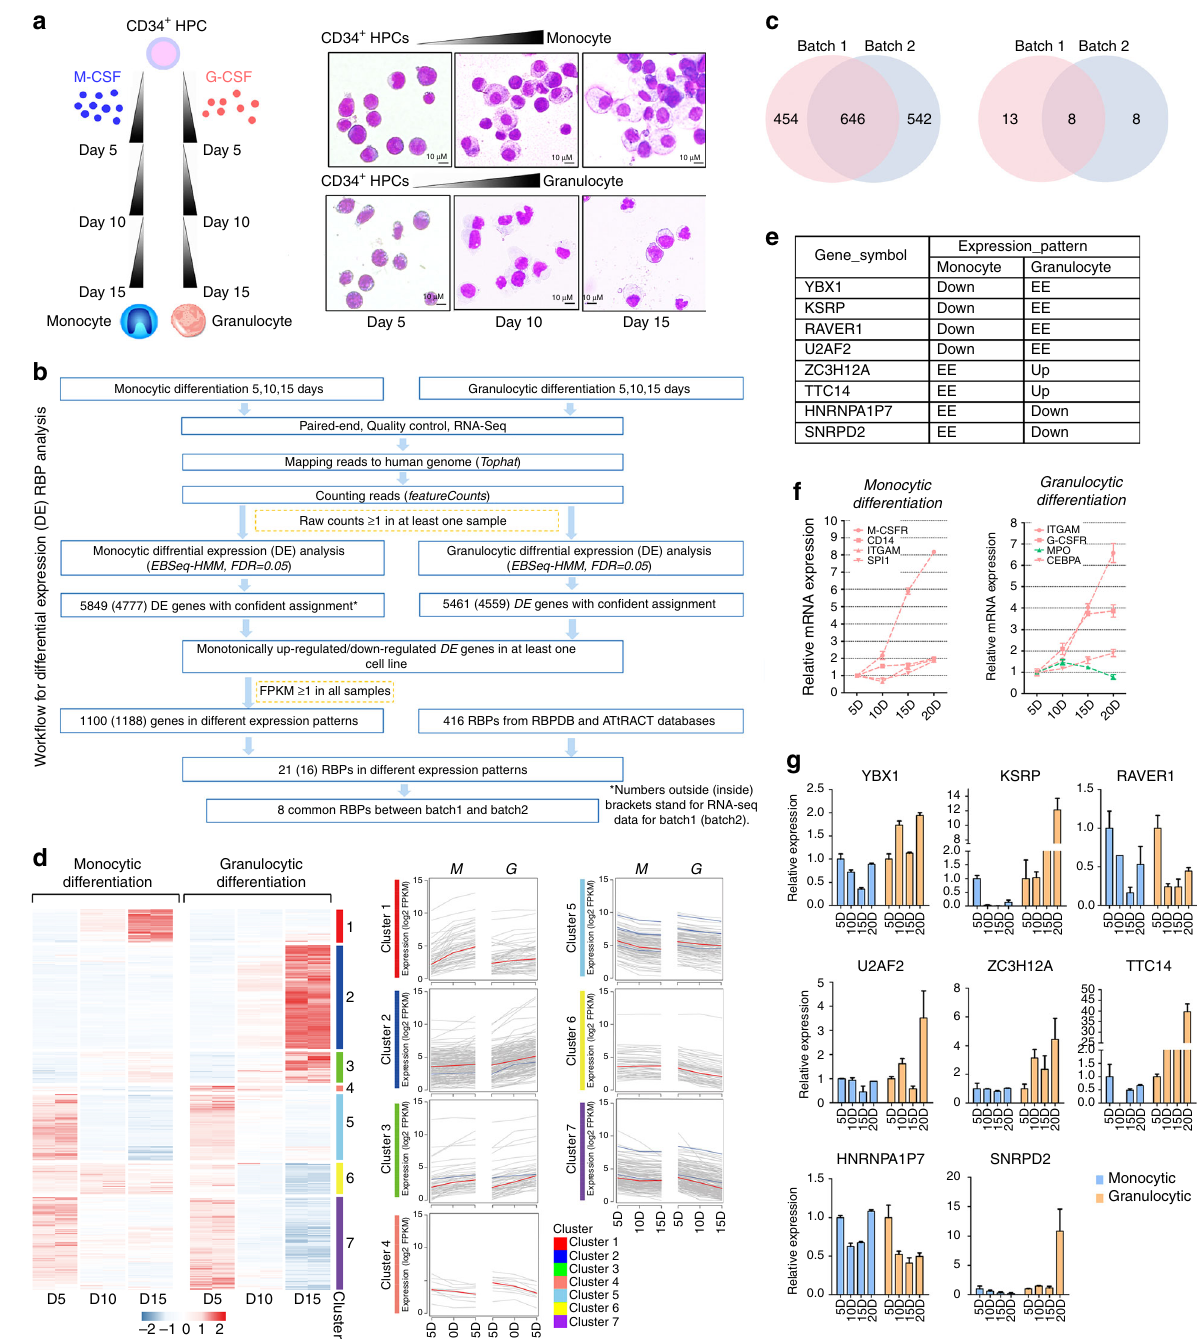
Fig. 1 RNA-seq identi fi es differentially expressed RBPs. a A schematic representation of the procedure used to prepare the samples for the RNA-seq analysis (left). CD34 + HPCs obtained from cord blood were differentiated into either the monocyte or granulocyte lineage, and cells were collected at 5, 10 and 15 days for the RNA-seq analysis. Temporal morphological changes (May-Grunwald Giemsa staining) in differentiated HPCs (Right). Magni fi cation, 40×. b The work fl ow for differential expression (DE) RBP analysis. c Overlap of the global differentially expressed genes in b (left) or differentially expressed RBP genes (right) between batch 1 and batch 2. d Left panel: heat map showing temporal expression of genes during monocytic or granulocytic differentiation of CD34 + HPCs in duplicate samples from batch 1 and batch 2. Right panel: K-means clustering of the temporal pro fi les of the differentially expressed genes (DEGs) divided into seven individual clusters. RBP genes are shown as blue lines. e RNA-seq data for potential RBP genes that regulate myeloid differentiation. ‘ Up ’ or ‘ Down ’ represent a gene that is monotonically up-regulated or downregulated in the corresponding culture, respectively, whereas ‘ EE ’ indicates a gene that is not a DEG in this cell culture. f qPCR analysis of M-CSFR, CD14 , ITGAM and SP1 mRNA expression during monocyte differentiation and ITGAM , G-CSFR, CEBPA and MPO mRNA expression during granulocyte differentiation. Up-regulated genes were shown in red and downregulated gene was shown in green. Three technical replicates from a single experiment. g qPCR analysis of the expression of the eight candidate RBP mRNAs during monocyte and granulocyte differentiation. Three technical replicates from a single experiment. Data are shown as means ±